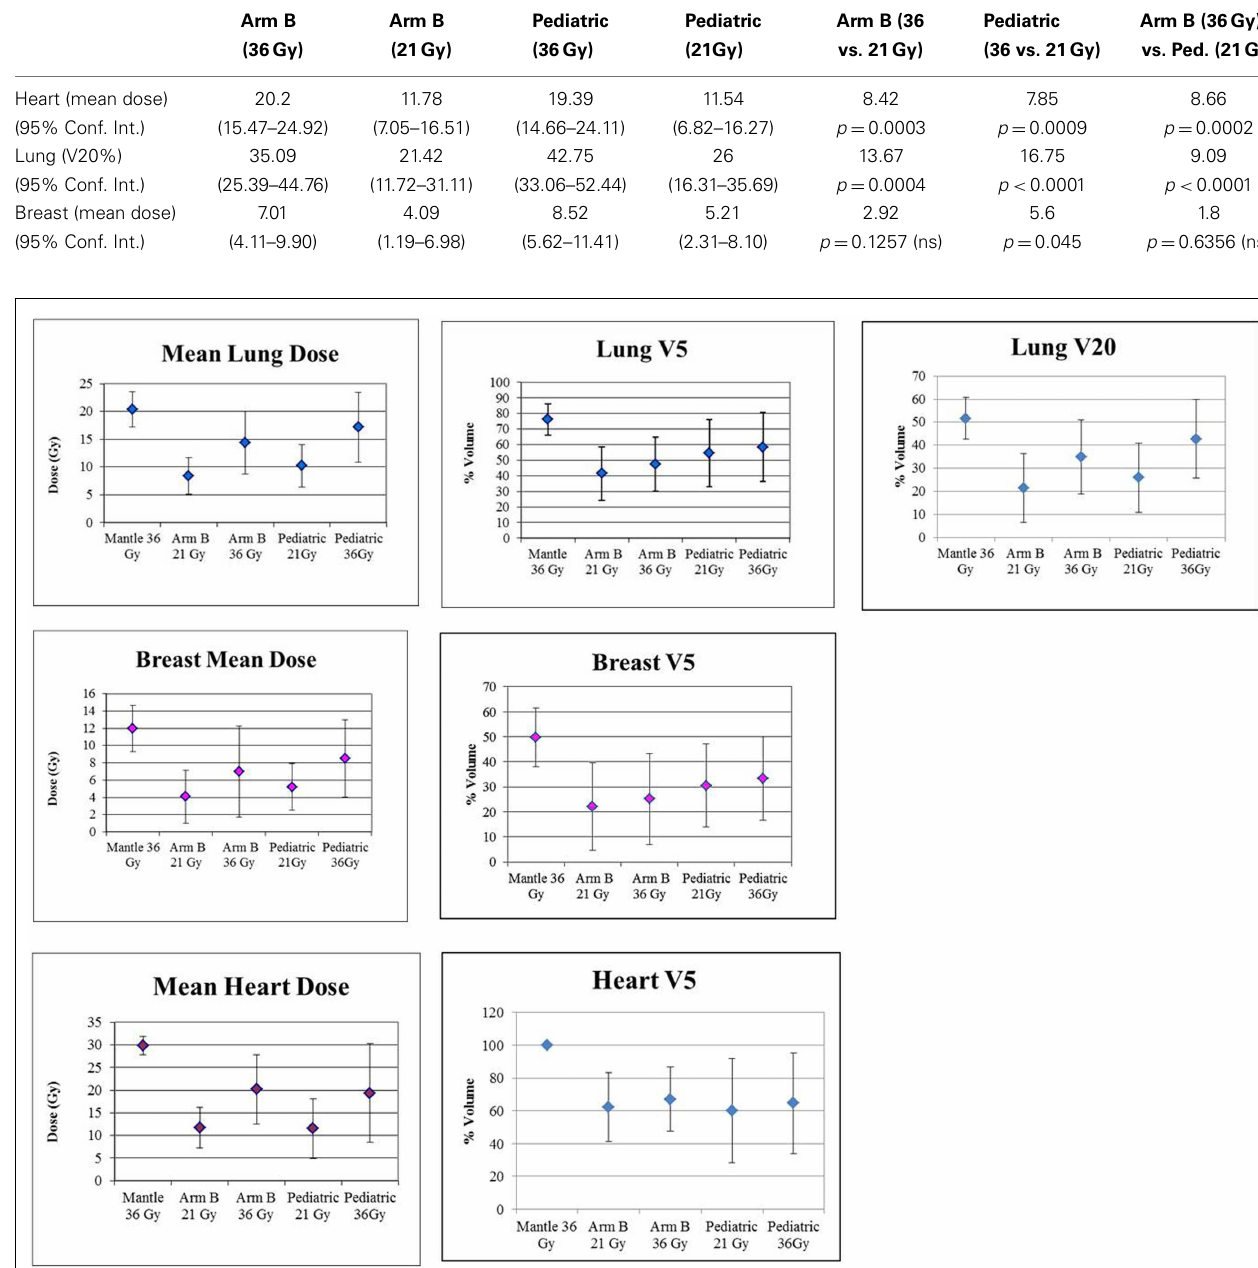
Table 5 | Impact of dose reduction on normal tissue dose by treatment arm .